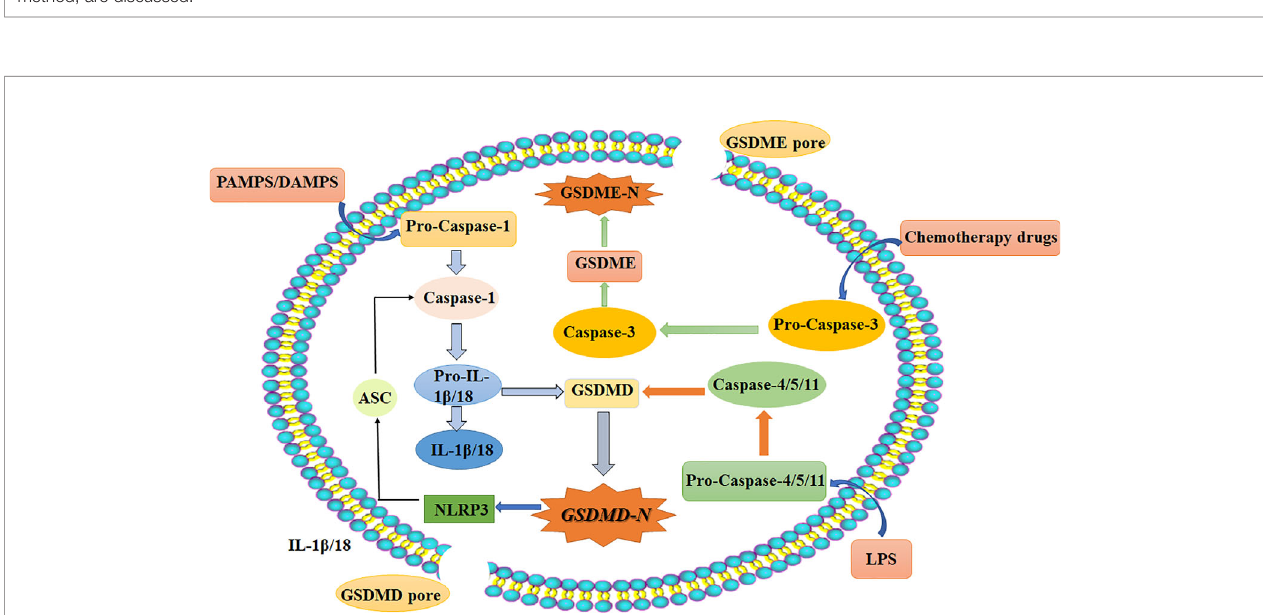
FIGURE 2 | Schematic diagram of the three main pyroptosis pathways: Classical pathways that rely on caspase-1/NLRP3/GSDMD; Independent of caspase-1, through the nonclassical pathway caspase-4/5/11; (1). Bacteria, viruses, and in fl ammatory factors can activate NOD-like receptors (NLRs), absentin melanoma2 (AIM2) or pyrin domains (PYD) through pathogen-associated molecular patterns (PAMPs) or noninfectious stimulation-associated damage-associated patterns (DAMPs). (2). Lipopolysaccharide (LPS) could directly activate caspase-4/5/11, mediate the activation of GSDMD, activate NLRP3 in fl ammasome, and maturation and release of IL-1 b and IL-18. (3). Chemotherapy drugs induce caspase-3 to cleave gasdermin E into GSDME-N and punch holes in the cell membrane to turn apoptosis into pyroptosis. Chemotherapy-induced caspase-3/GSDME speci fi c pathways. DAMPs, damage-associated molecular patterns (noninfectious stimuli); PAMPs, pathogen-associated molecular patterns; LPS, lipopolysaccharide (gram-negative bacteria cell wall component); ASC, apoptosis-associated speck- like protein containing a CARD; IL, interleukin; NLRP3, NOD-like receptor protein 3; caspase, caspase family of proteins; GSDMD, gasdermin D.